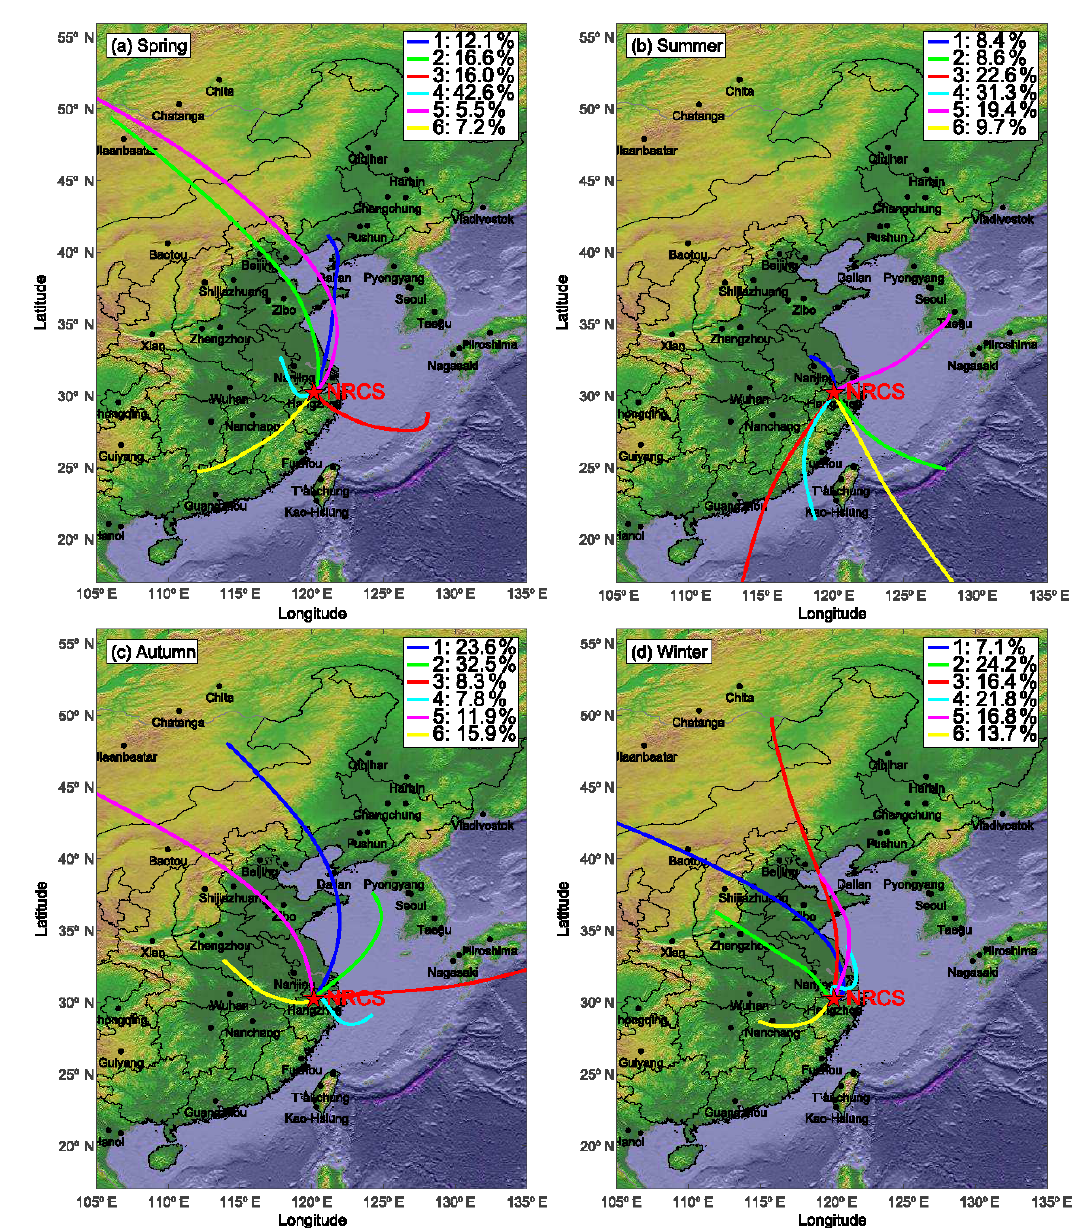
Figure 5. Seasonal cluster analysis of the 72h air mass back trajectories starting at 100m from the NRCS site in